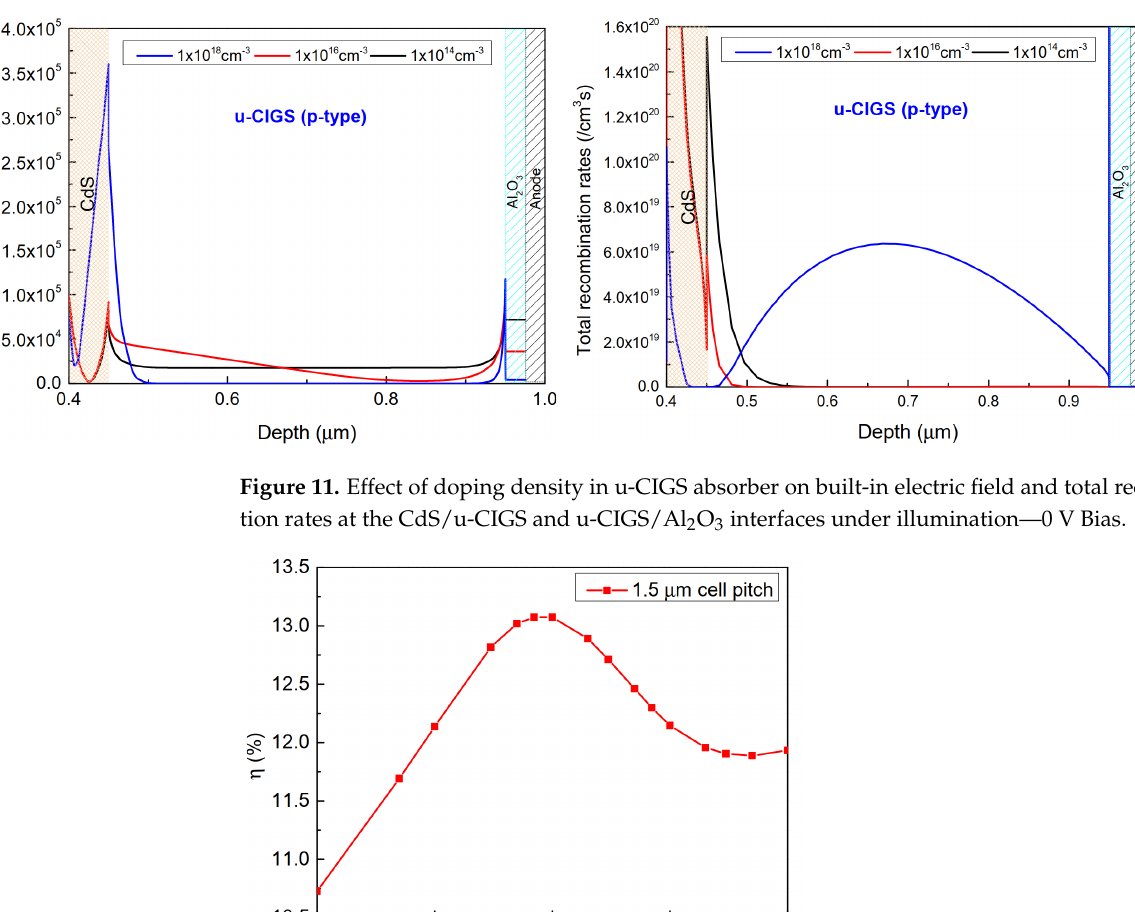
Figure 10. PV characteristics of u-CIGS cells for different cell pitches and different absorber doping densities.